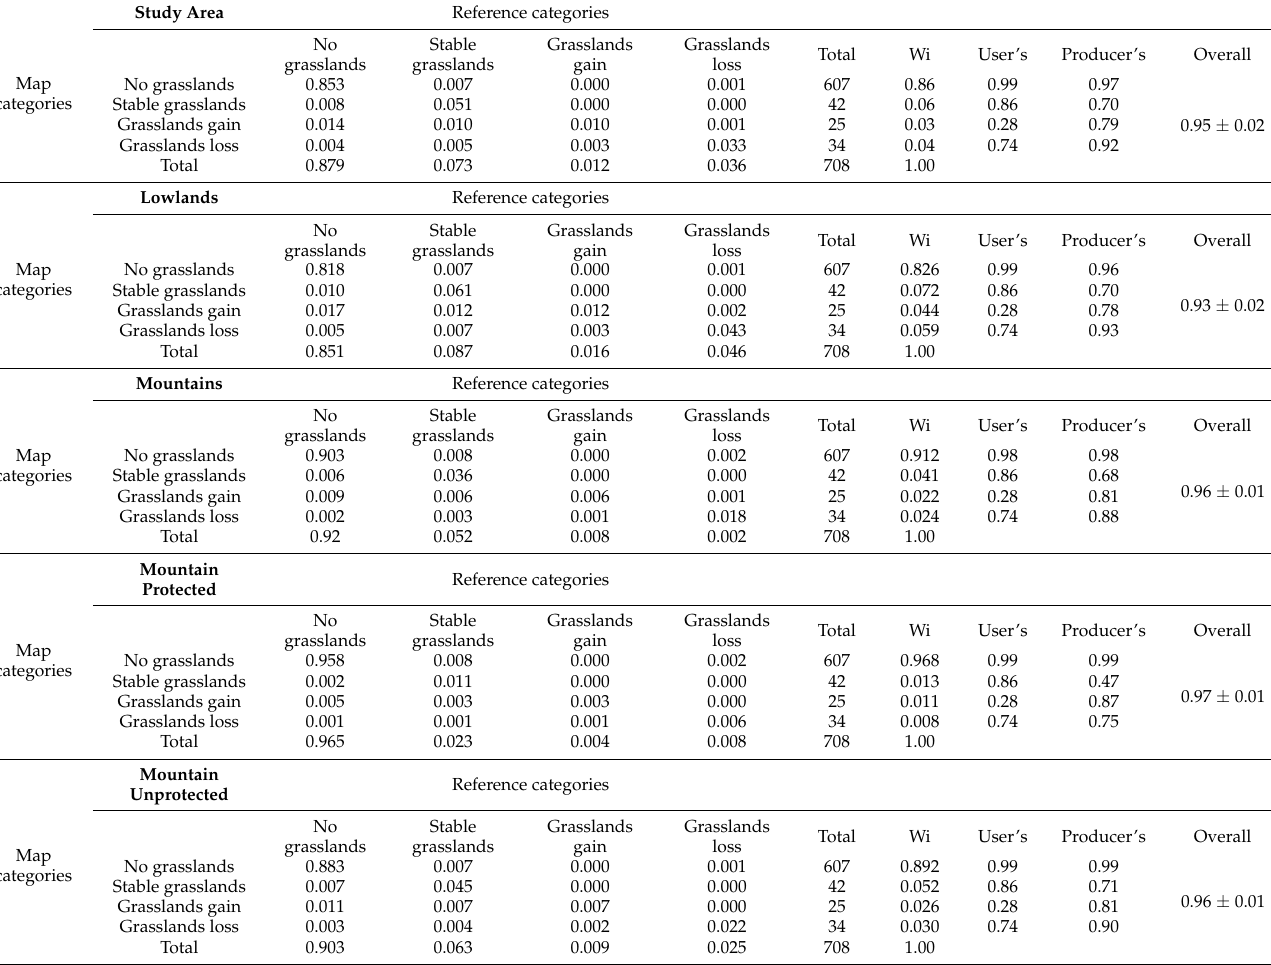
Table 4. Estimated error matrix for each extent of analysis (study area, lowlands, mountains, mountain protected and mountain unprotected) with cell entries expressed as the estimated proportion (p ij ) of area in cel ij. Overall, user’s and producer’s accuracies with 95% confidence intervals. Appendix B gives the error matrix as sample counts (n ij , left) and estimated proportions (p ij , right).